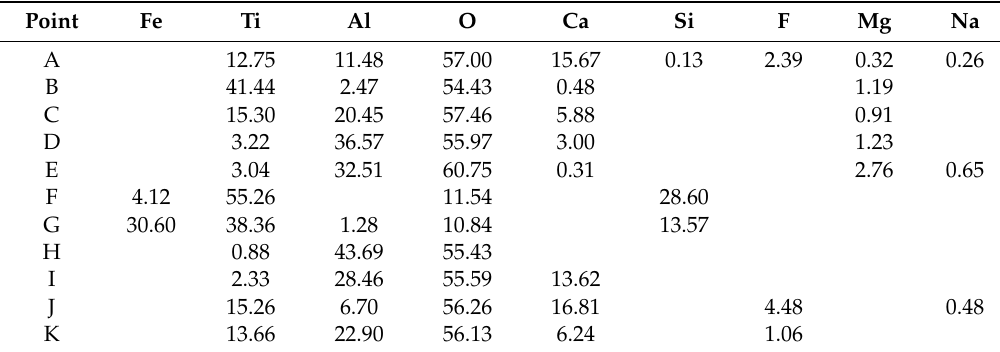
Table 2. The atomic proportions of phases in Figure 6, %.